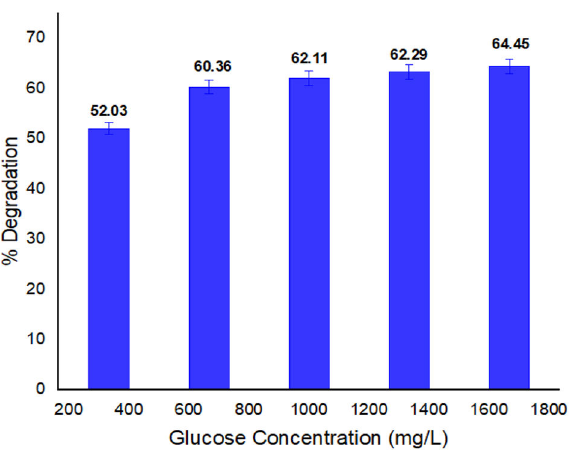
Figure 6. Glucose concentration and its impact on percent degradation of methyl